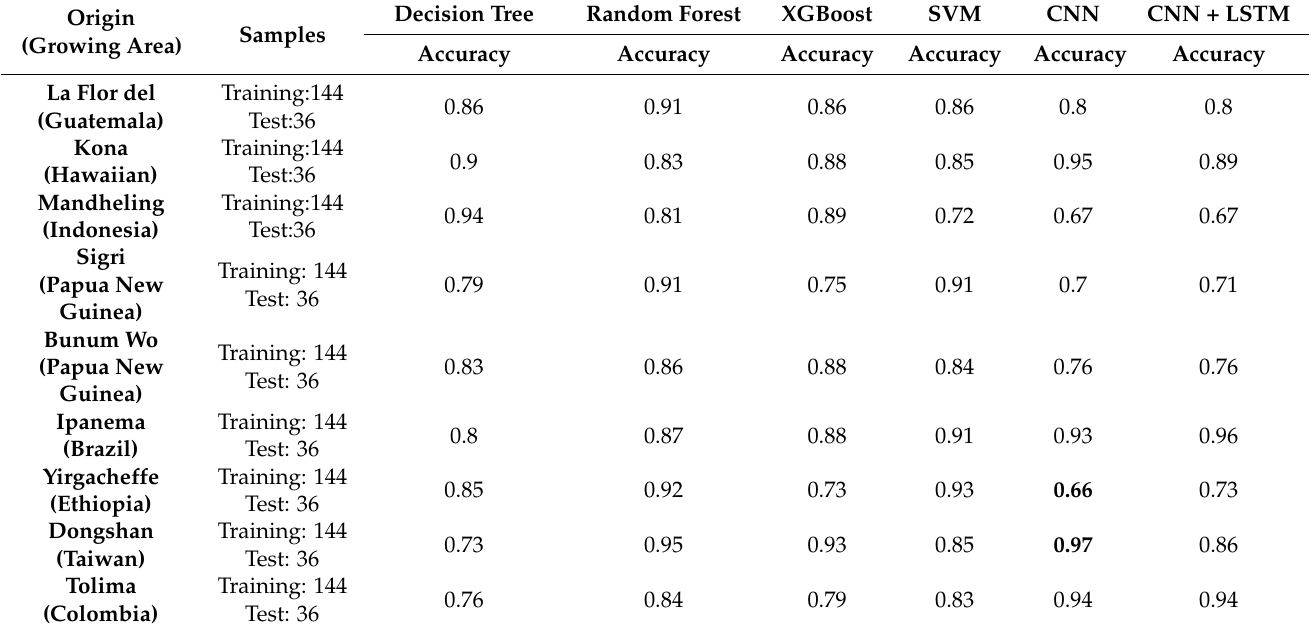
Table 3. Classifier performance results in scenario using 9-class predictions (experiment